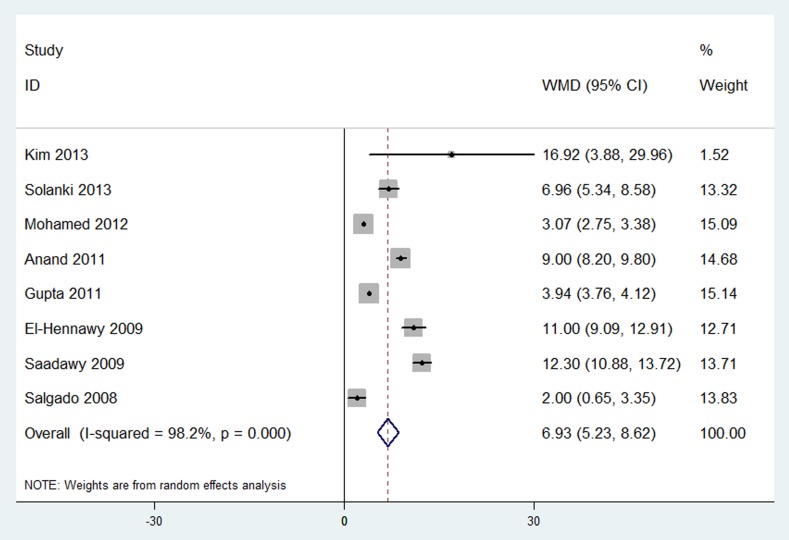
Forest plot: Postoperative analgesic duration.